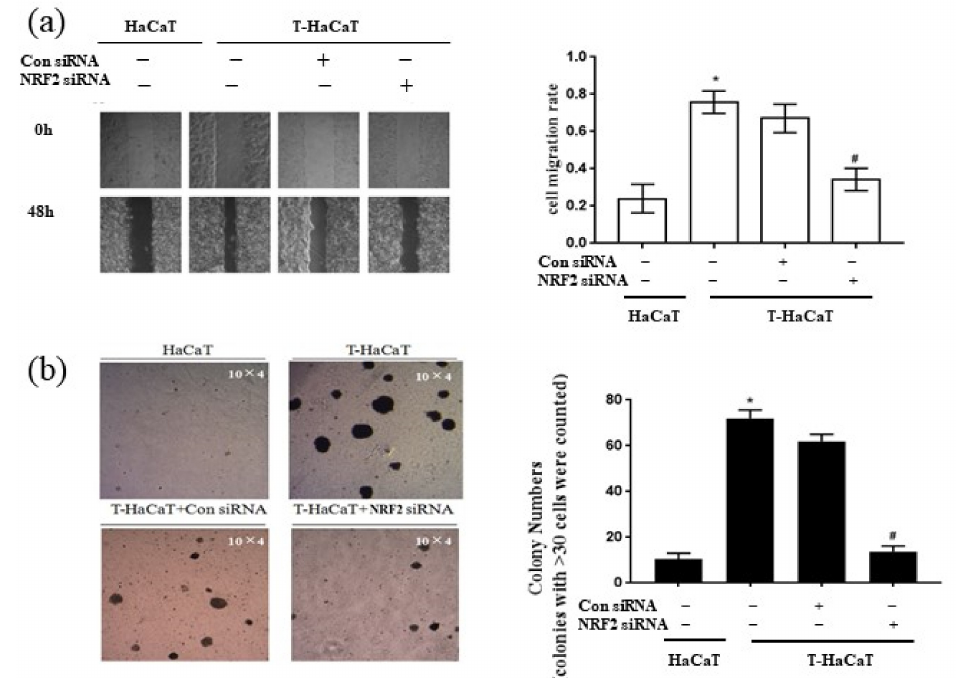
Figure 4. The cell migration rate and the colony number in T-HaCaT cells after transfection NRF2 . ( a ) Wound-healing assay (Scheme 10 × 4) and the rate of migration. ( b ) Colony formation assay and colony numbers. Error bars are the mean ± SD ( n = 3). * Compared with HaCaT cells, p < 0.05; # Compared with control siRNA cells, p <